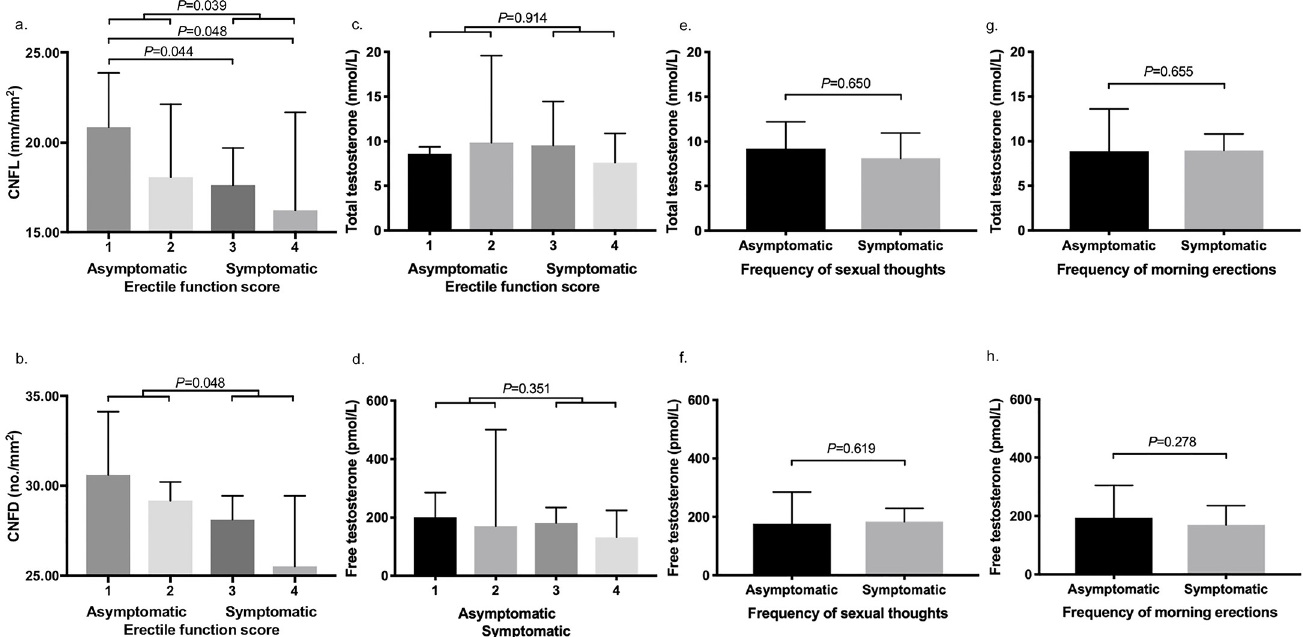
Fig 1. Comparison of corneal nerve parameters in asymptomatic and symptomatic patients based on erectile function score (a & b) and comparison of total and free testosterone levels between asymptomatic and symptomatic patients based on erectile function (c & d), frequency of sexual thoughts (e & f), and frequency of morning erections (g & h). CNFL and CNFD are both significantly lower in symptomatic compared to asymptomatic patients with erectile dysfunction (a & b). Data are presented as mean and standard deviation for normally-distributed variables and median and interquartile range for